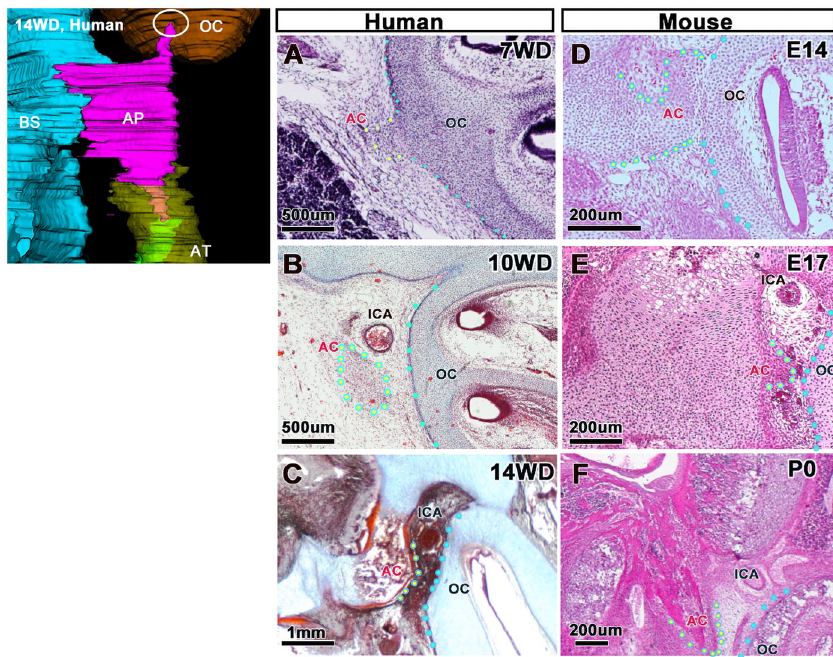
Fig 7. Temporary continuity between the posterior end of the AP and the OC. (A–C) Posterior end of the AP and the OC in humans. (D–F) Posterior end of the AP and the OC in mice. The timing of separation of the AP from the OC differs between humans and mice. AP, alar process; AT, ala temporalis; BS, basisphenoid; ICA, internal carotid artery; OC, otic capsule.